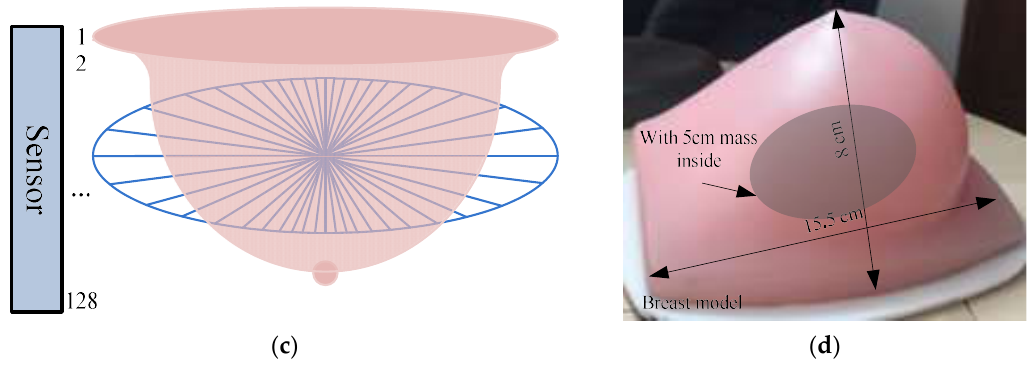
Figure 8. Ultrasound tomography transducer acquisition setup. ( a ) Placement of breast in the ring; ( b ) Transducer ring configuration platform; ( c ) Slice maps of ultrasound tomography imaging; ( d ) Breast Model.